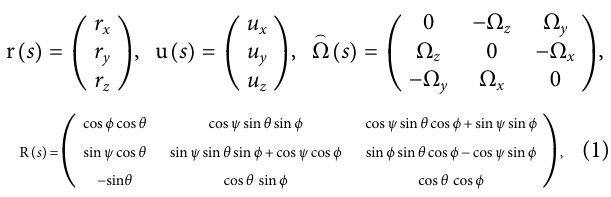
Frontiers in Robotics and AI |